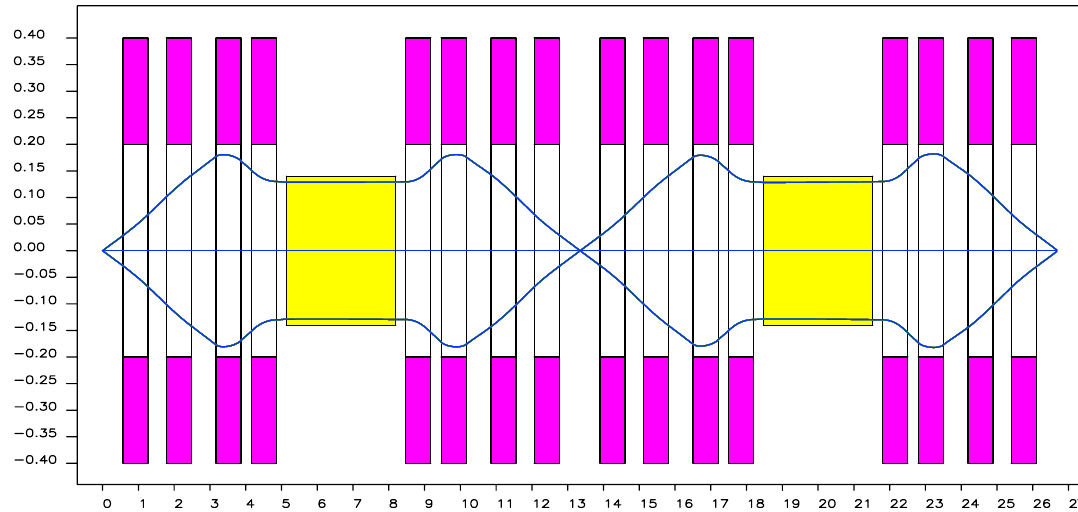
FIG. 2. (Color) First order vertical beam envelope corresponding to an initial beam emittance of (cid:10) 1 mm , (cid:10) 50 mrad , and (cid:10) 16% energy dispersion. Yellow (light) boxes represent dipoles and the magenta (dark) boxes represent multipoles with appropriate apertures. The multipoles have two apertures: the larger (colored) represent the horizontal while the smaller (inner, white) represent the vertical